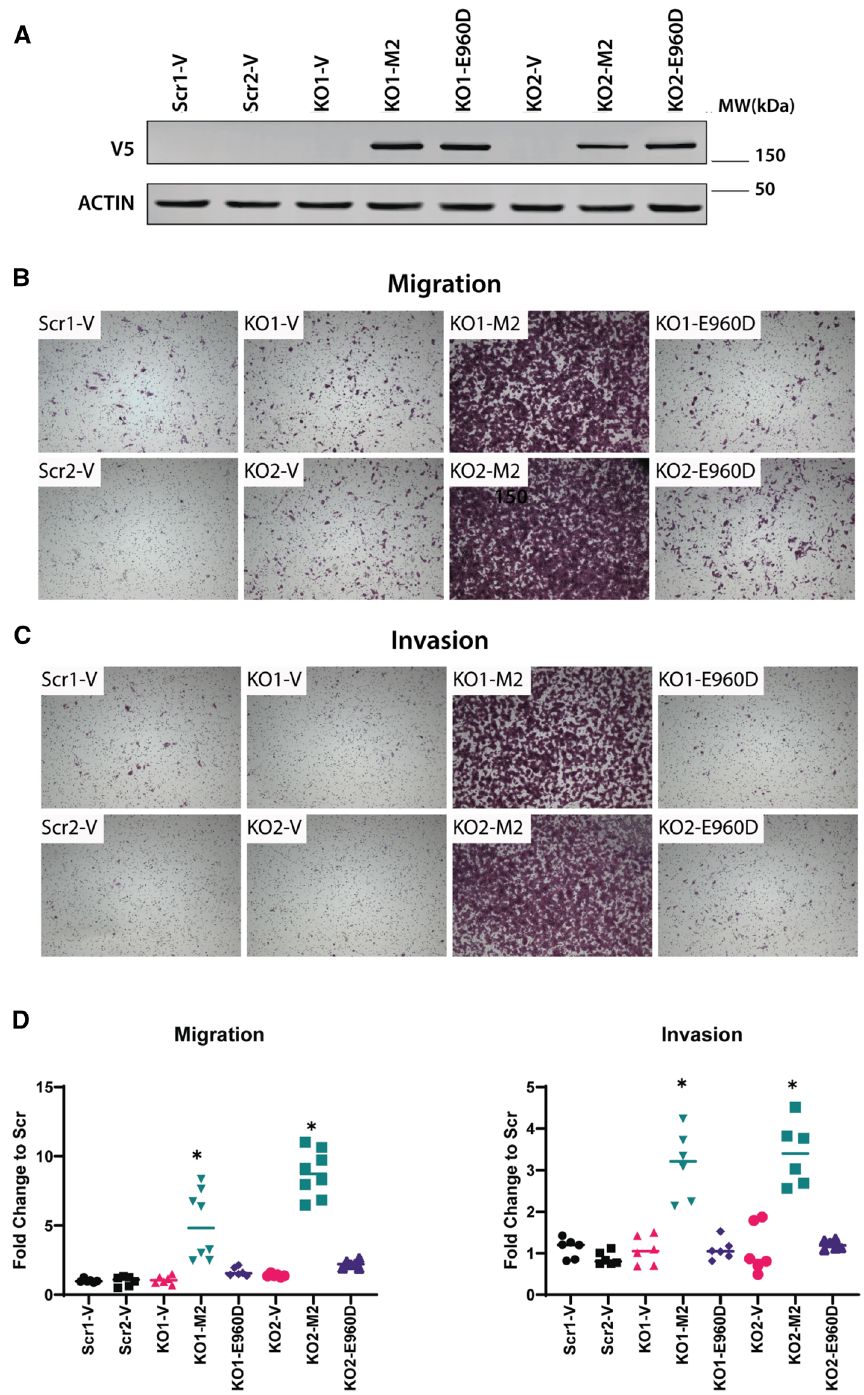
Figure 2. High TRPM2 expression increases invasion and migration in neuroblastoma. ( A ) Western blotting was performed on two clones of SH-SY5Y scrambled control cells (Scr1-V, Scr2-V), TRPM2 KO (KO1-V, KO2-V), and TRPM2 KO cells reconstituted with either TRPM2 (KO1-M2, KO2-M2) or the E960D calcium-impermeant TRPM2 mutant (KO1-E960D, KO2-E960D). Probing with anti-V5 antibody demonstrated successful TRPM2 transfection. Full length gels for Western blots are shown in Supplementary Fig. S1. Migration ( B ) and invasion ( C ) assays were performed as described in Methods, and representative pictures from Boyden chambers are shown. ( D ) Analysis of migration and invasion density of two clones each of scrambled, KO, and KO cells reconstituted with TRPM2 or E960D was performed. Symbols indicate individual wells and are shown for Scr-V (black), KO-V (red), KO-M2 (green), and KO-E960D (blue) cells. Medians are indicated for 3 independent experiments with a line. Each of the three experiments had 2 wells/clone/group (total replicates = 6) except for the KO-M2 clones in one migration experiment, which had 4 wells/group (replicates = 8). Statistical difference of each group compared to scrambled controls were analyzed by one-way ANOVA. * p <